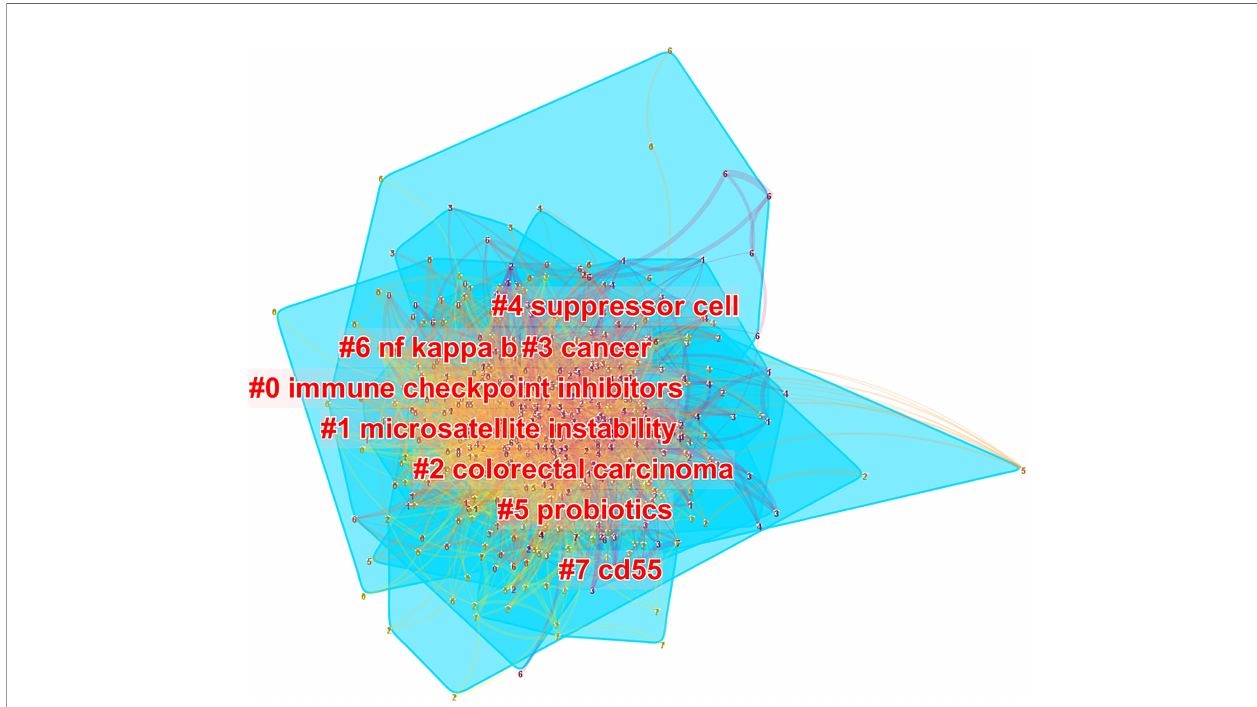
FIGURE 7 | The cluster of keywords related to colorectal cancer immunotherapy. The different colors represented different clusters. Each point represents a keyword, and the number on the node represents the cluster to which the keyword belongs. The lines between the points represent two keywords with co- occurrence relationship. The color of the line segment represents the year, from 2012 to 2021, the color changes from purple to yellow. The blue blocks represent the extent of each cluster in the network space.